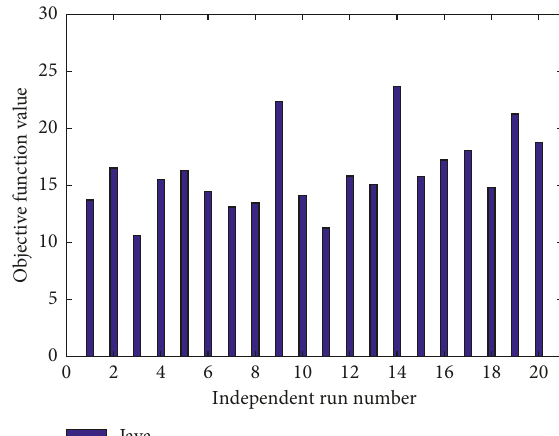
Figure 9: Convergence characteristics for the 8-bus system by NLP formulation.